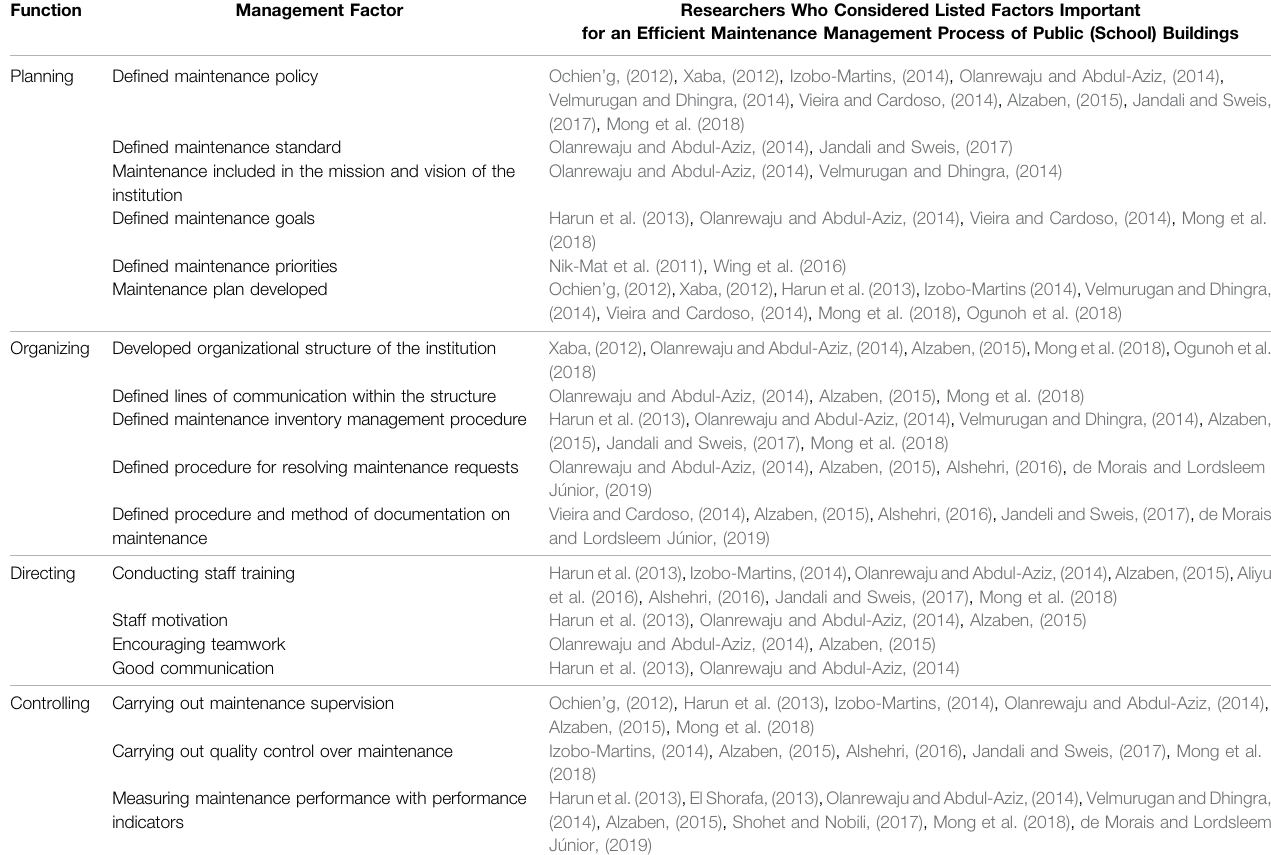
TABLE 1 | Factors for school buildings effective maintenance management.